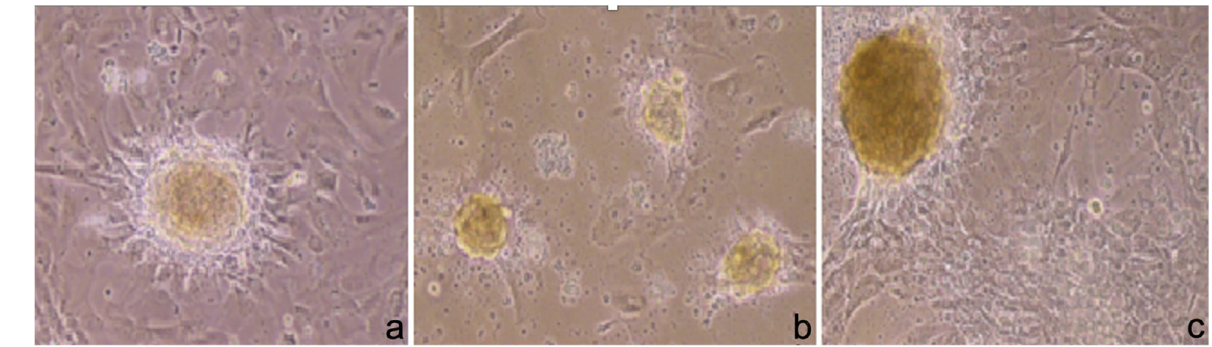
Figure 2. Cell aggregates in culture medium after 5 days ( a ), after 10 days ( b ), and after 14 days ( c ) (10 × magnification with a phase-contrast microscope).